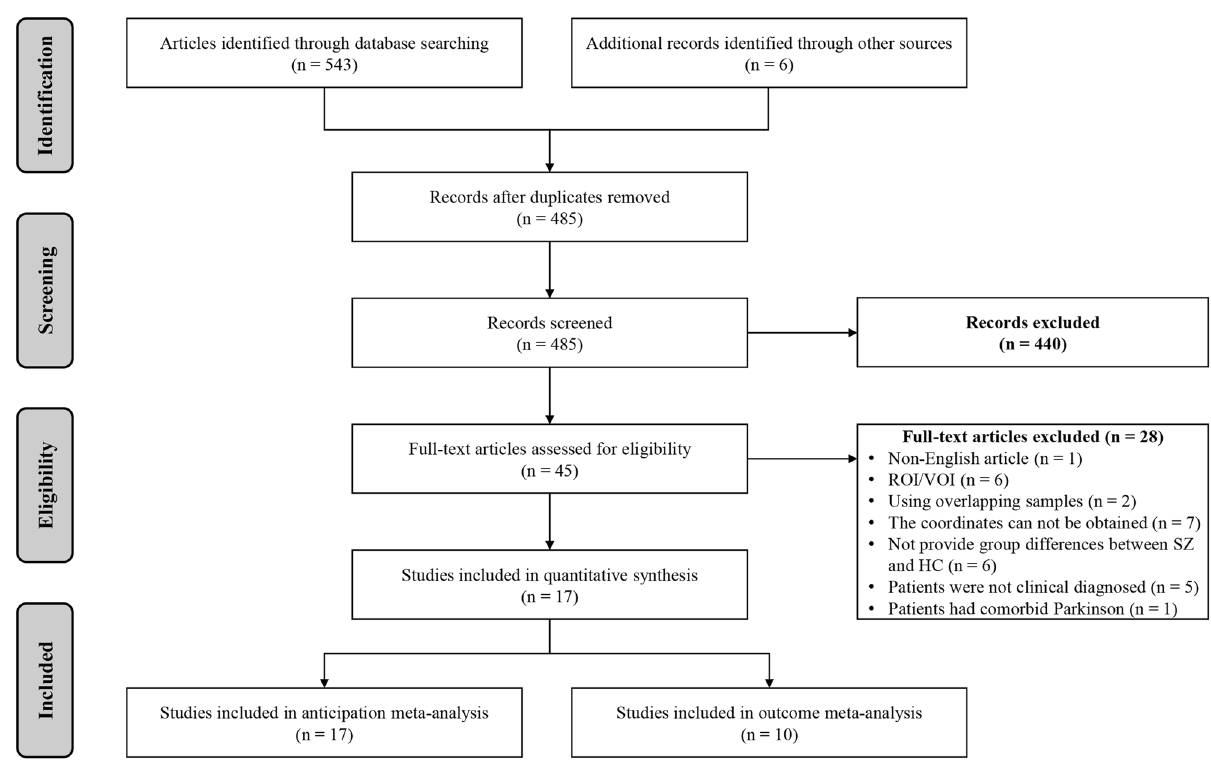
Fig. 1 Preferred reporting items for systematic reviews and meta-analyses (PRISMA) fl ow diagram. Of 548 articles initially identi fi ed, a total of 17 studies were enrolled for the reward anticipation meta-analysis, and 10 studies were enrolled for the fi nal reward outcome meta- analysis. MID monetary incentive delay, fMRI functional magnetic resonance imaging, ROI regions of interest, VOI volume of